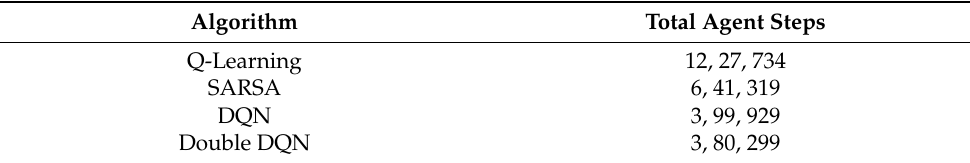
Figure 13. Path Traversed by the Agent with E = 5000 and Varying Discount Rate ( a – c ) Q-Learning ( d – f ) SARSA ( g – i ) DQN ( j – l ) Double DQN. Also, in some cases like in Figure ( b , j ) and Figure ( c , d ), there was no change in path or the agent does not respond at all. Table 4. Total Agent Steps for Different Reinforcement Learning